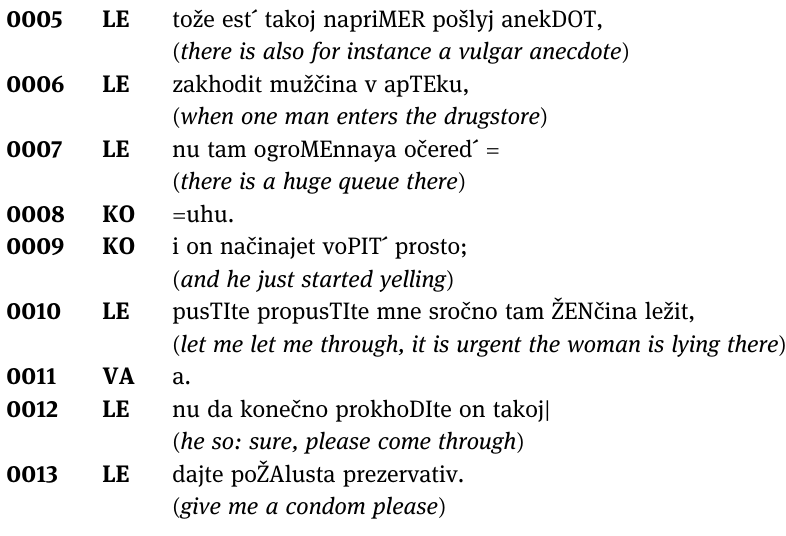
 9 The laugh syllables with the voiced vowel /a/ were rare in the